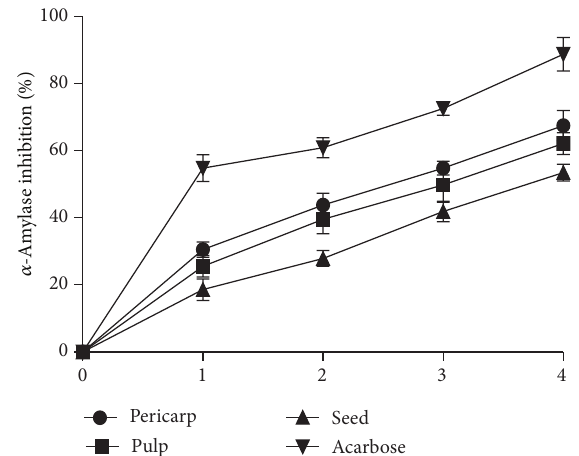
Figure 1: Percentage of 𝛼 -glucosidase inhibition by extracts from Soursop fruit part and acarbose. The concentrations of the extract used for the plot are 0.00, 0.20, 0.40, 0.6, and 0.80 mg/mL. The con- centrations of the acarbose used for the plot are 0.00, 10.00, 30.00, and 40.00 𝜇 g/mL. Values represent mean of standard deviation of triplicate